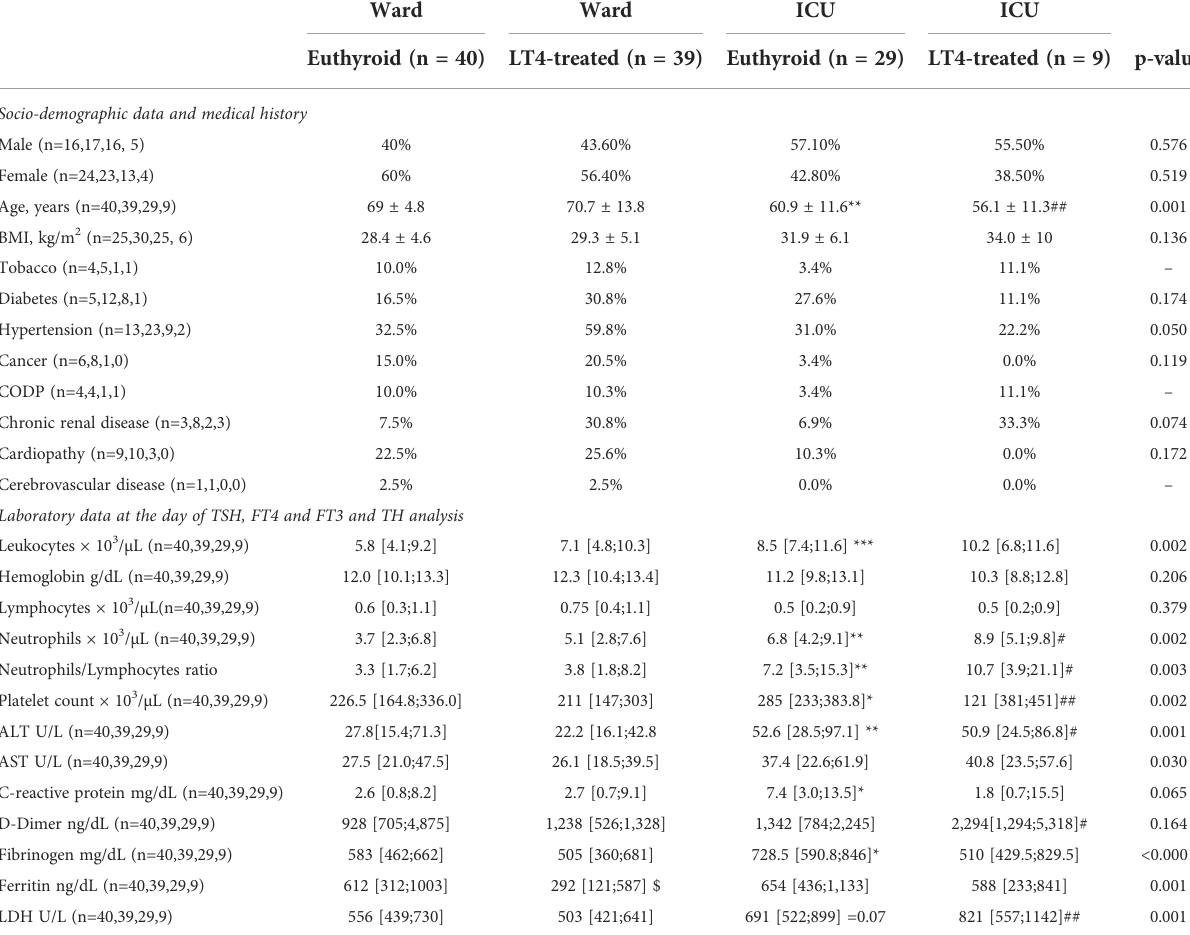
TABLE 1 Baseline characteristic and laboratory data in hospitalized COVID-19 patients.